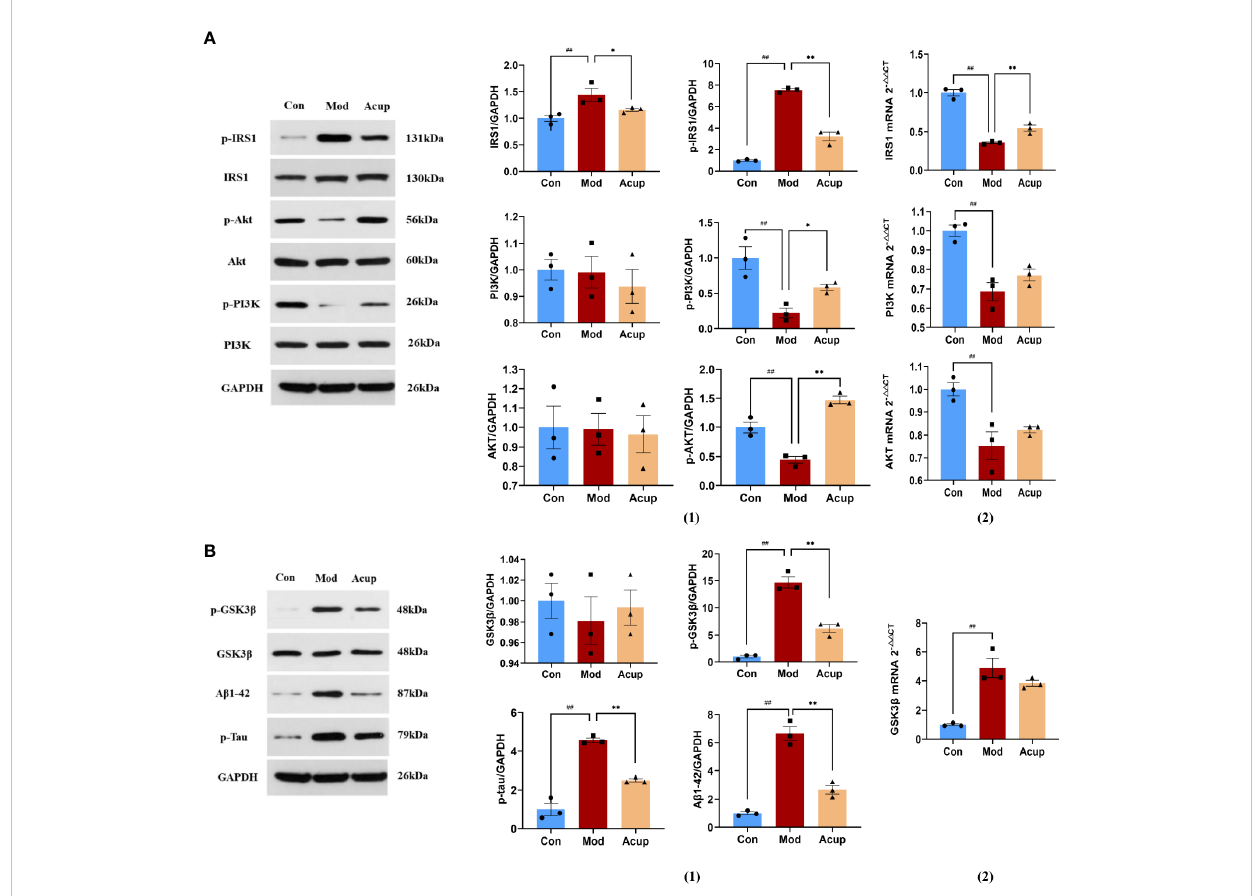
FIGURE 6 Electroacupuncture regulates the expression of key proteins of the insulin signaling pathway. (A) (1) Western blotting and quantitative analysis of IRS1, p-IRS1, PI3K, p-PI3K, AKT, and p-AKT expression in the hippocampus of mice in the three groups; (2) RT-PCR analysis of IRS1, PI3K and AKT mRNA expression in the hippocampus of mice in the three groups. (B) (1) Western blotting and quantitative analysis of GSK3 b , p-GSK3 b , A b and Tau expression in the hippocampus of mice in the three groups; (2) RT-PCR analysis of GSK3 b mRNA expression in the hippocampus of mice in the three groups. Data are expressed as means ± SEM. Mod vs Con, ## p < 0.01; Acup vs Mod, * p < 0.05, ** p <